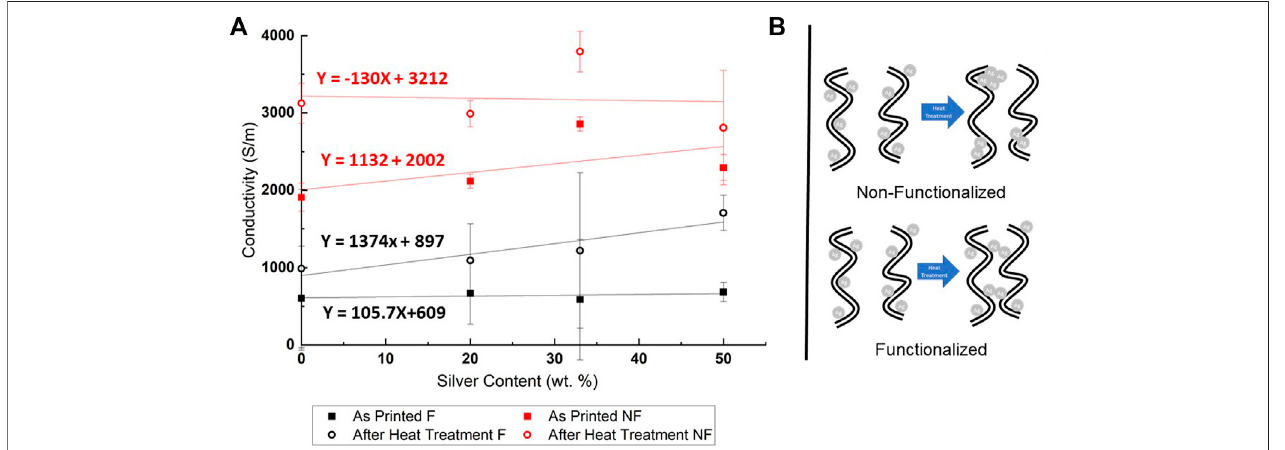
FIGURE 6 | (A) Calculated conductivities of functionalized (F) and pristine (NF) silver decorated CNTs, before and after re fl ow oven heat treatment. (B) Proposed mechanism of nanoparticle agglomeration after sintering of pristine (non functionalized - NF) and functionalized (F) CNTs.